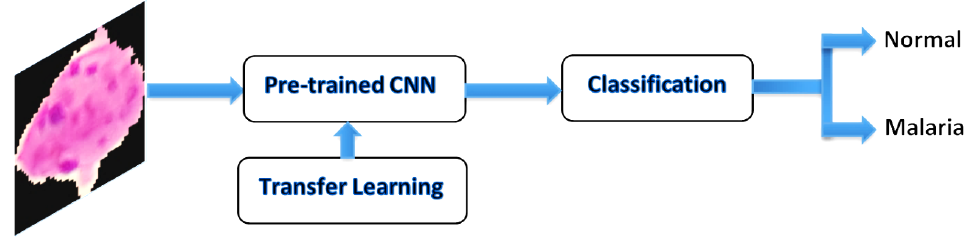
Figure 5. Convolutional neural network (CNN) transfer learning.